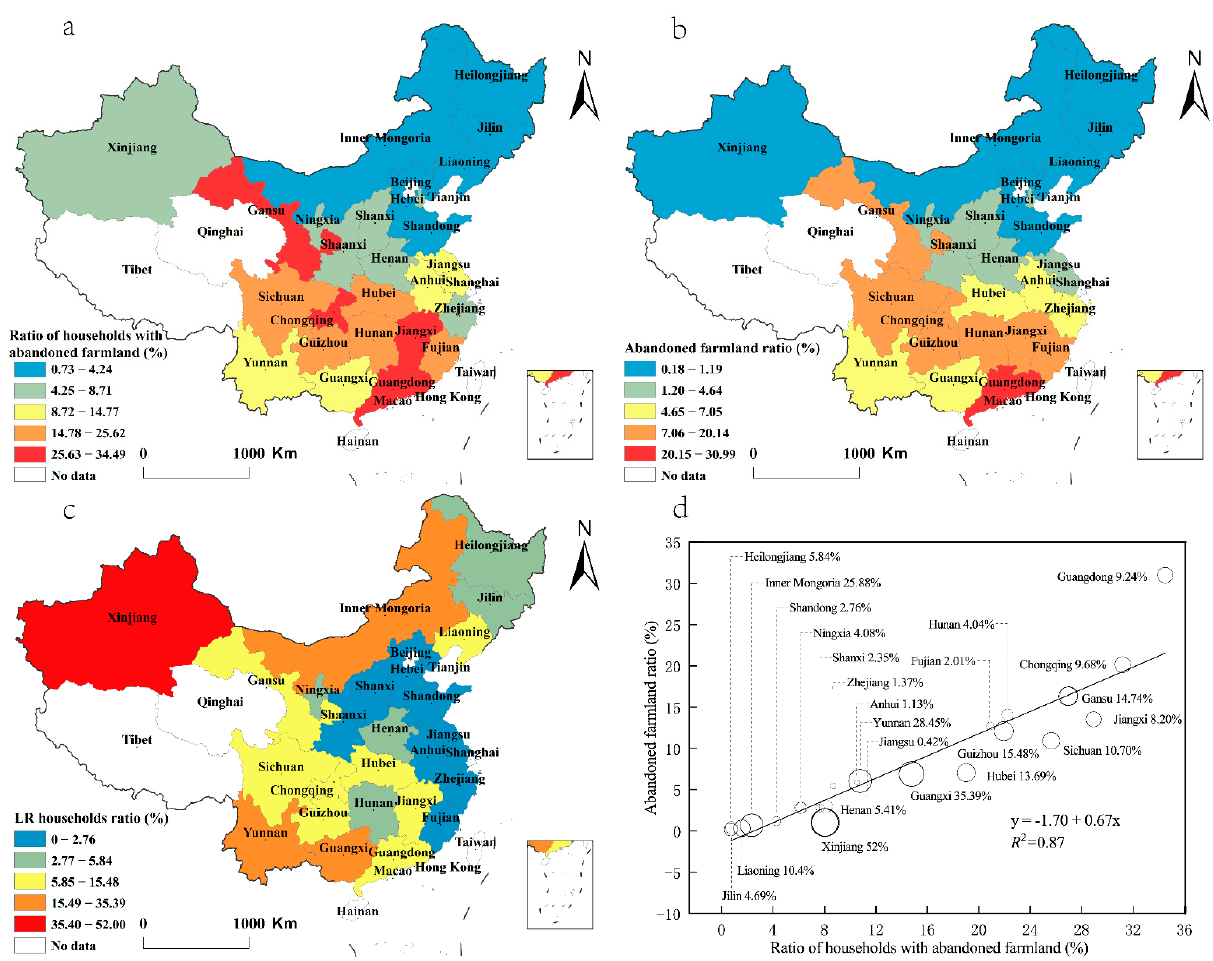
Figure 4. Farmland abandonment and livestock raising. ( a ) Ratio of households with abandoned farmland in different provinces. ( b ) Abandoned farmland ratio in different provinces. ( c ) LR household ratio in different provinces. ( d ) Relationship between farmland abandoned household ratio and farmland abandonment ratio. The size of the circle indicates LR household ratio. Note: There is only one sample in Beijing. Considering the statistical error of small samples, it is not displayed.